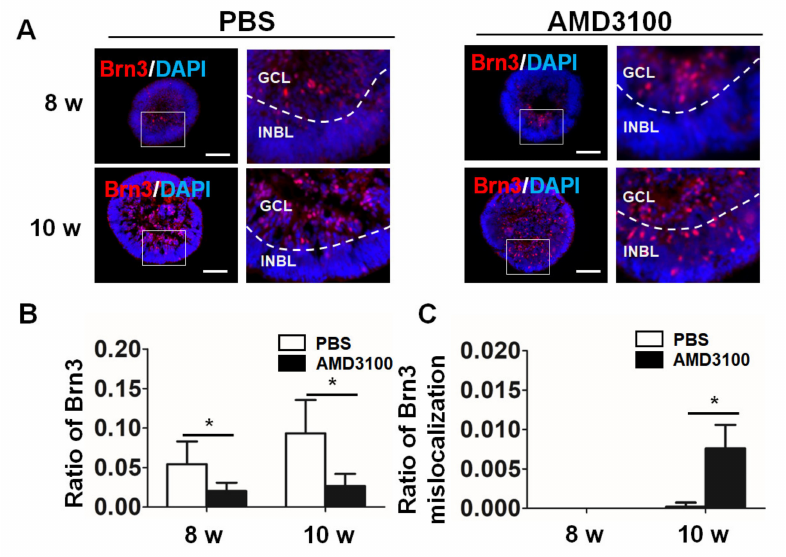
Figure 6. CXCR4 blockade decreases the ratio of mature ganglion cells and results in their mislocal- ization in retinal organoids. ( A ) Ganglion cells were stained for BRN3 (marker for mature ganglion cells) from 6 weeks to 10 weeks, and the staining of BRN3 was mislocalized in INBL in the AMD3100 treatment group. ( B ) The relative ratio of BRN3-positive cells to all cells (nuclei were stained with DAPI) significantly decreased in the AMD3100 group (* p < 0.05, n = 15) at 10 weeks. ( C ) The relative ratio of BRN3-positive cells to all cells (nuclei were stained with DAPI) located in the INBL significantly increased in the AMD3100 group (* p < 0.05, n = 15) at 10 w. Scale bars: 100 µ